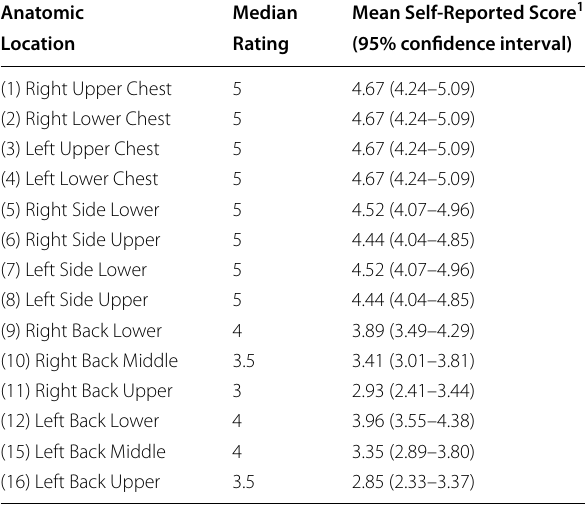
Anatomic location is visually demonstrated in Fig. 1 Mean Self-Reported Score 1 was recorded as a 5-point Likert scale from 1 Hard to 5 Easy (1—Very Hard, 2—Hard, 3—Neutral, 4—Easy, 5—Very